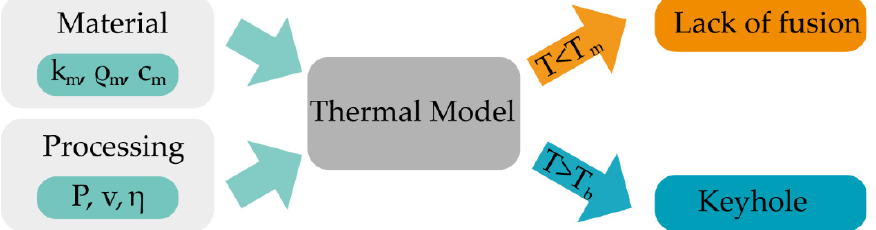
Figure 2. The framework for estimating the layer-dependent printability of the copper/steel bimetal. Processing parameters (laser power (P), scanning velocity (v), and powder catchment efficiency ( η )) and layer-dependent effective material properties [35] (effective thermal conductivity (k m ), effective specific heat (c m ), and effective density ( ρ m )) are provided to the thermal model.